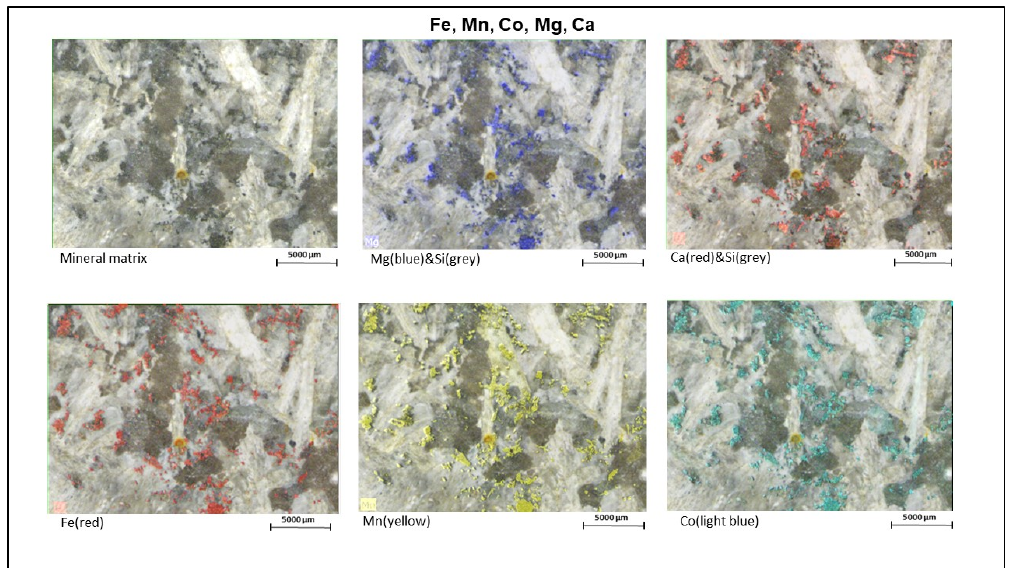
Figure 9. Elemental spatial micrometric distribution of Ca, Mg, Fe, Mn, and Co in the mineral matrix.